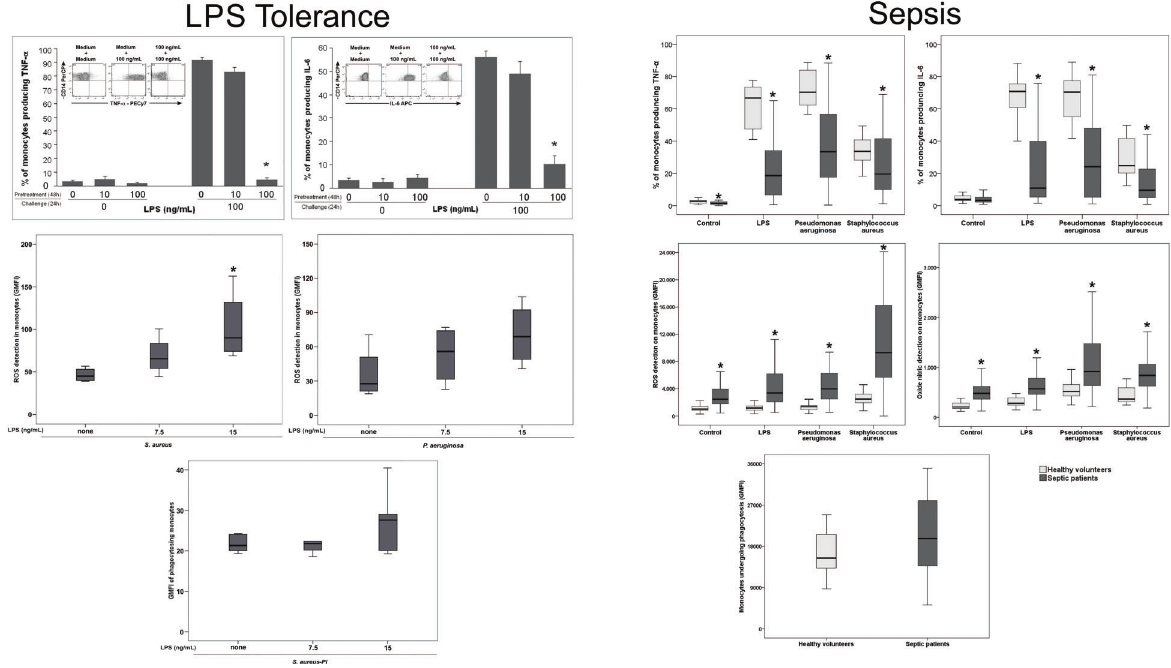
Figure 2. Similarities in monocyte functions observed in lipopolysaccharide (LPS)-induced tolerance and in septic patients evaluated at a cellular level by fl ow cytometry. Left panels represent modulated functions in LPS-tolerized monocytes: upper panels: reduced tumor necrosis factor (TNF)- a and interleukin (IL)-6 detection; middle panels: increased or preserved reactive oxygen species (ROS) generation; lower panel: preserved phagocytosis of S. aureus. Right panels represent modulated functions in monocytes from septic patients: upper panels: reduced TNF- a and IL-6 detection; middle panels: increased ROS and NO generation; lower panel: preserved phagocytosis of E. coli . Adapted from (42,49,50). Reproduction licenses available at creativecommons.org/licenses/by/4.0/.